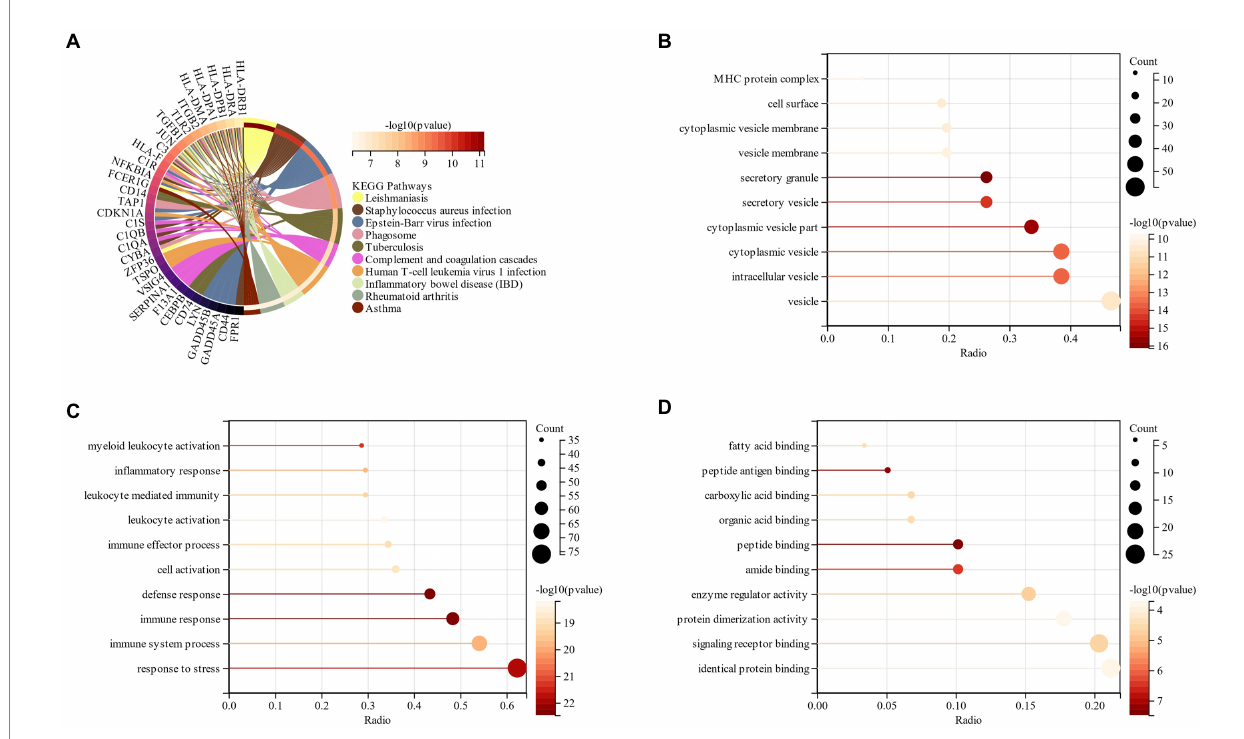
FIGURE 3 (A) KEGG analysis of schizophrenia CGs; (B) : GO analysis of cell composition (CC) of schizophrenia CGs; (C) : GO analysis of the biological process (BP) of schizophrenia CGs; (D) : GO analysis molecular function (MF) of schizophrenia